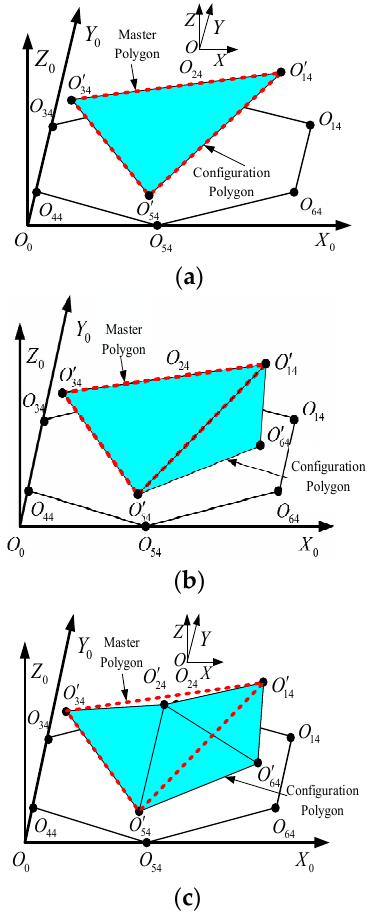
Figure 12. Analysis of main support polygon: ( a ) Configuration polygon with three stance legs, identification of light rough terrain, ( b ) configuration polygon with four stance legs, and ( c ) configuration polygon with five stance legs.